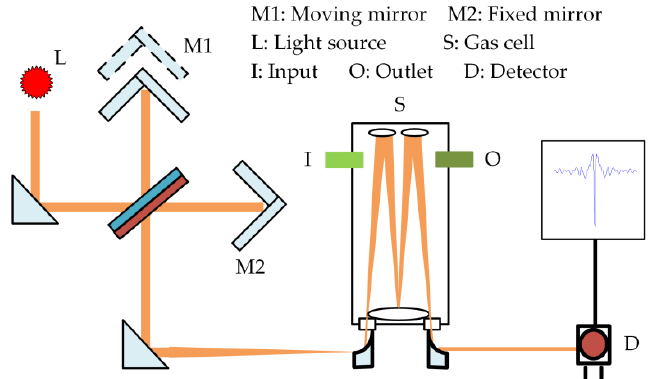
Figure 4. Working principle of portable Fourier transform infrared spectrometer.